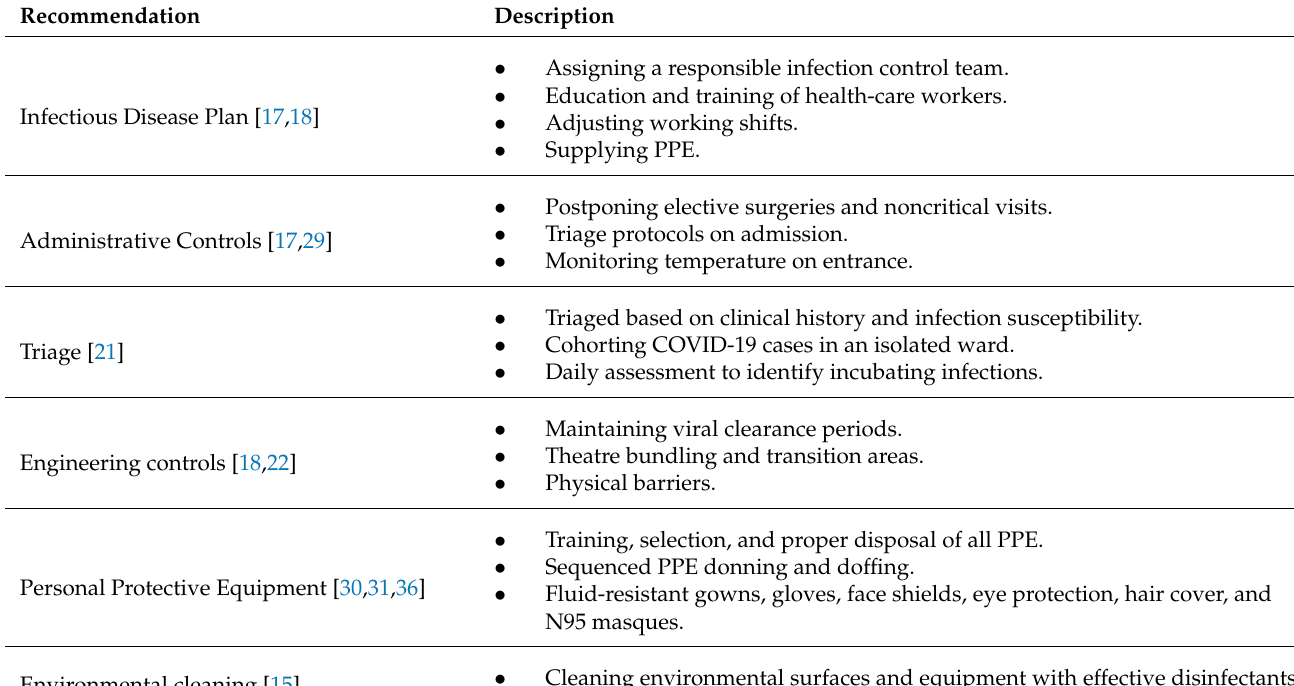
Table 2. Summary of IPC recommendations for